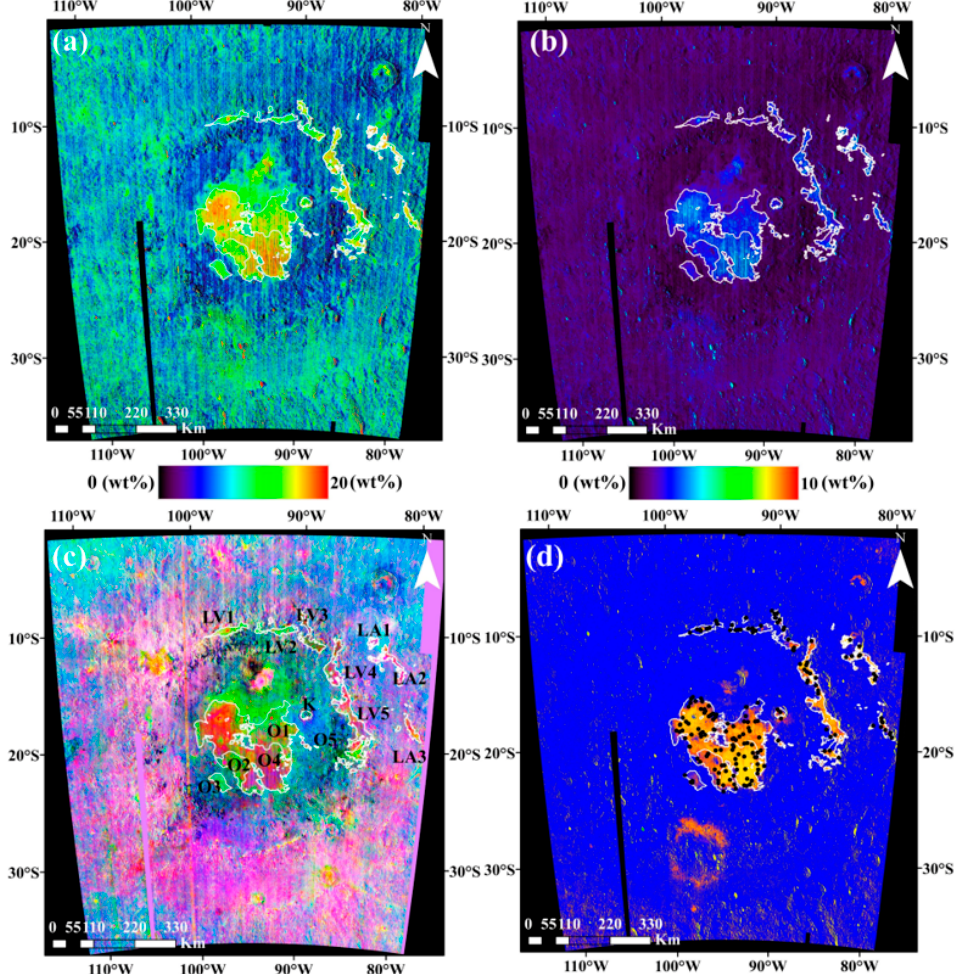
Figure 3. ( a ) FeO content retrieval result from M 3 data, ( b ) TiO 2 content retrieval result from M 3 data, ( c ) MNF–FCC image (R: G: B-Component 7: 9: 8), and ( d ) M 3 color composite image (R: G: B-IBD 1000: IBD 2000: M 3 1.578 µm) demonstrating the differences in the mineral composition of basaltic units. The black circles in the image point to the sites from which the reflectance spectra were sampled. Image projection: Stereographic centered at the Orientale